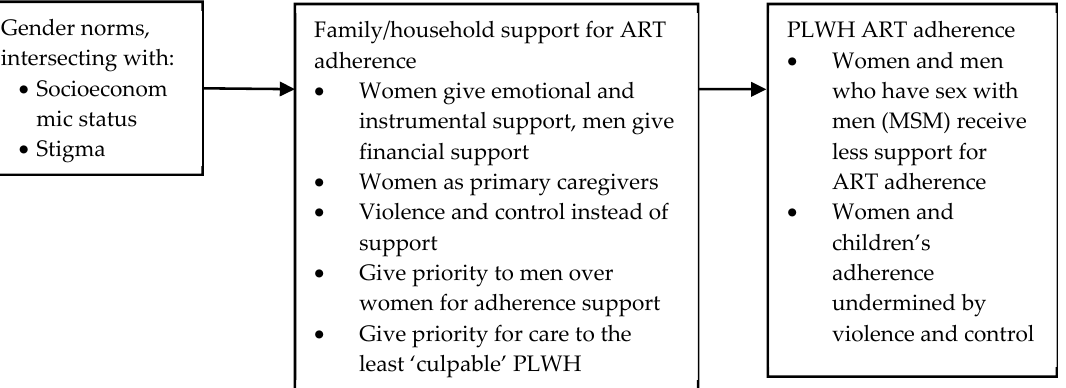
Figure 4. Studies examined the indirect impact of gender norms on ART adherence via household support